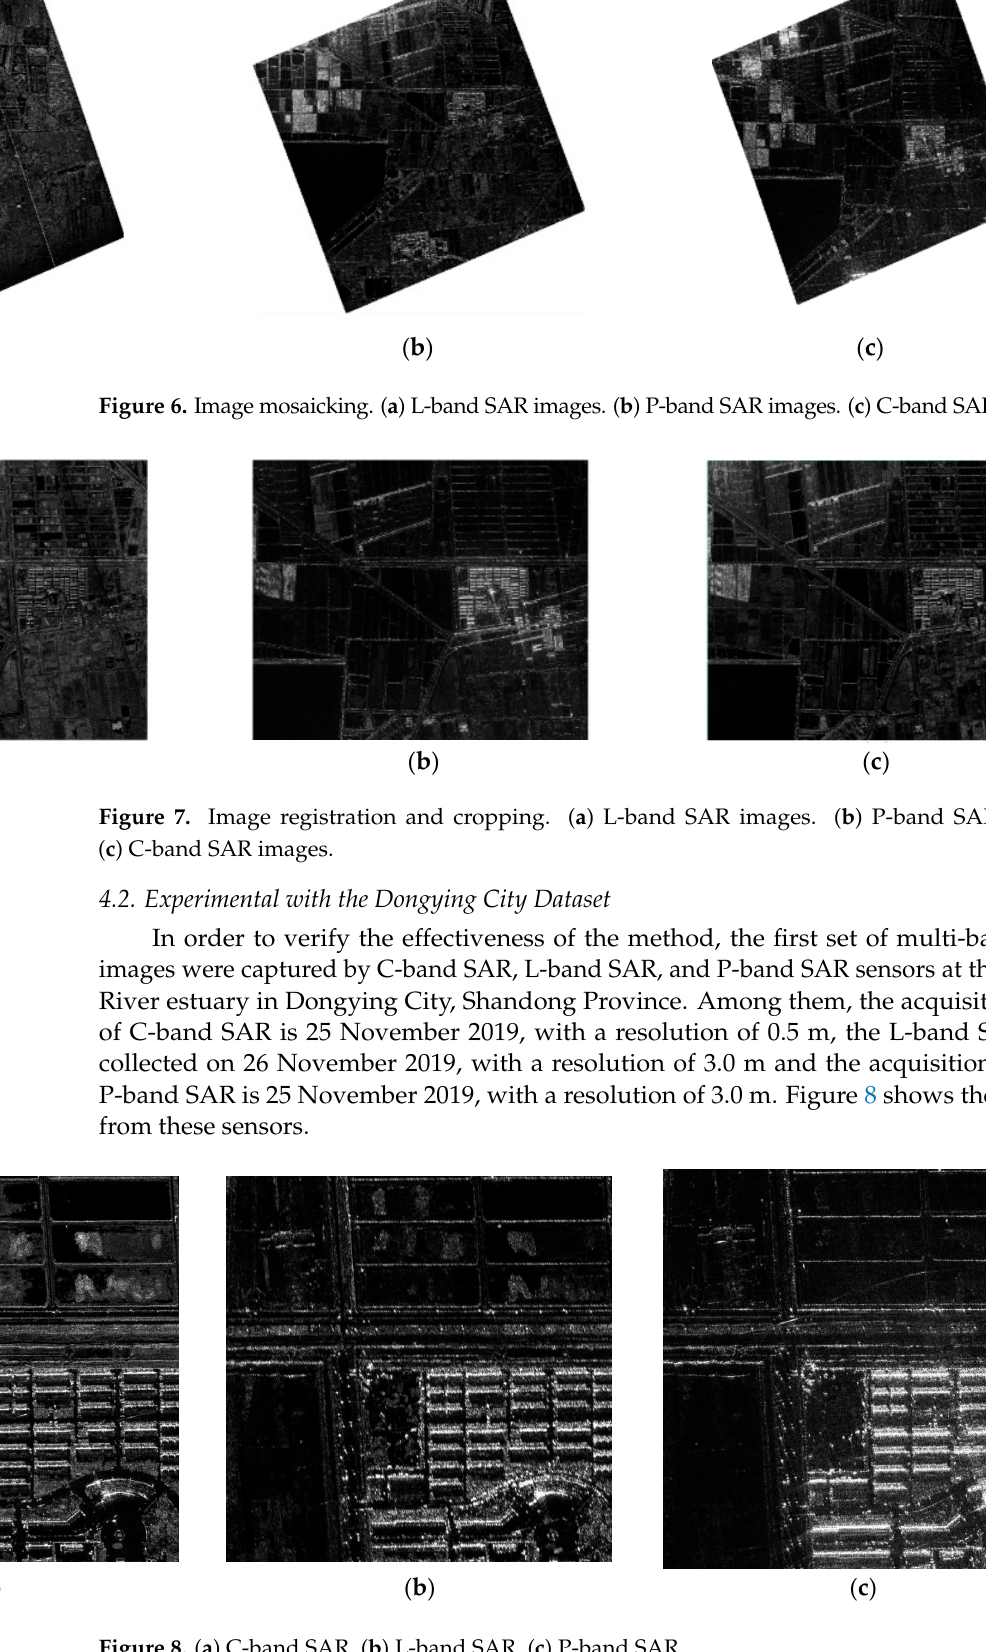
Figure 8. ( a ) C-band SAR. ( b ) L-band SAR. ( c ) P-band